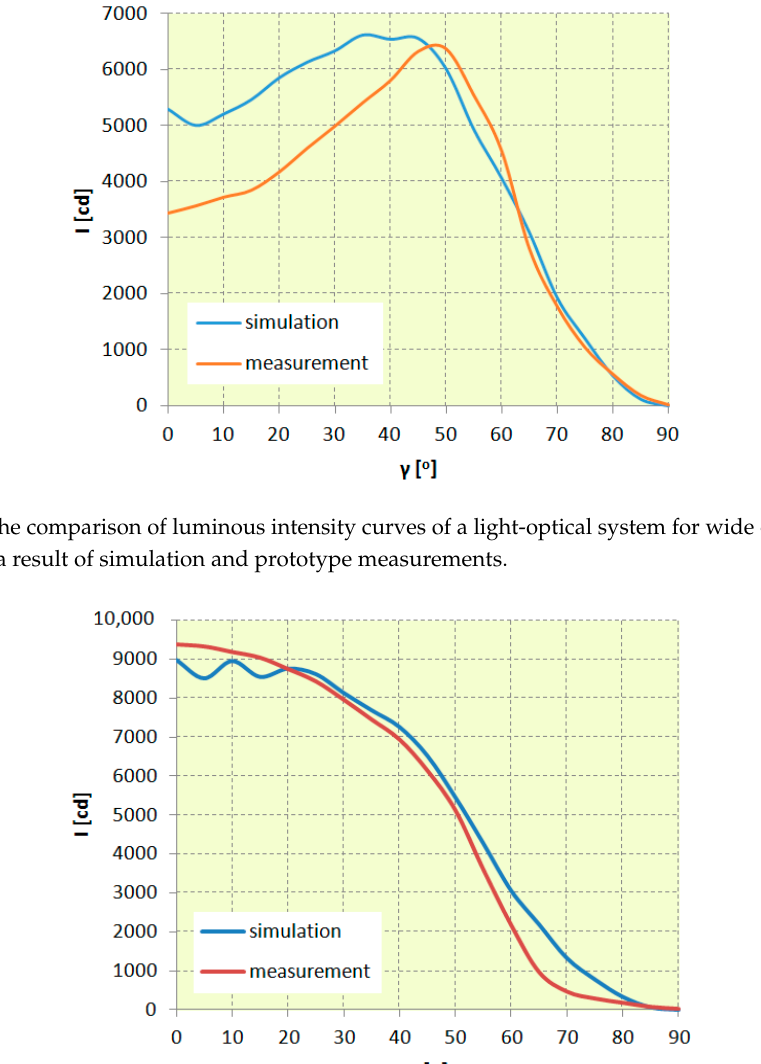
Figure 22. The comparison of luminous intensity curves of a light-optical system for narrow distribution obtained as a result of simulation and prototype measurements. The values of maximum luminous intensity in all analyzed cases differ from each other by less than 5%. Their curves depending on the angle of inclination of the reflectors are shown in Figure 23. The values of maximum luminous intensity for wide distribution are achieved at slightly different angles. In turn, the beam angles differ by no more than 3.5% in the case of wide and medium distribution, whereas for narrow distribution, the difference is bigger and amounts to 10%; however, it is still at an acceptable level. The change of beam angle depending on the inclination angle of reflectors is shown in Figure 24.